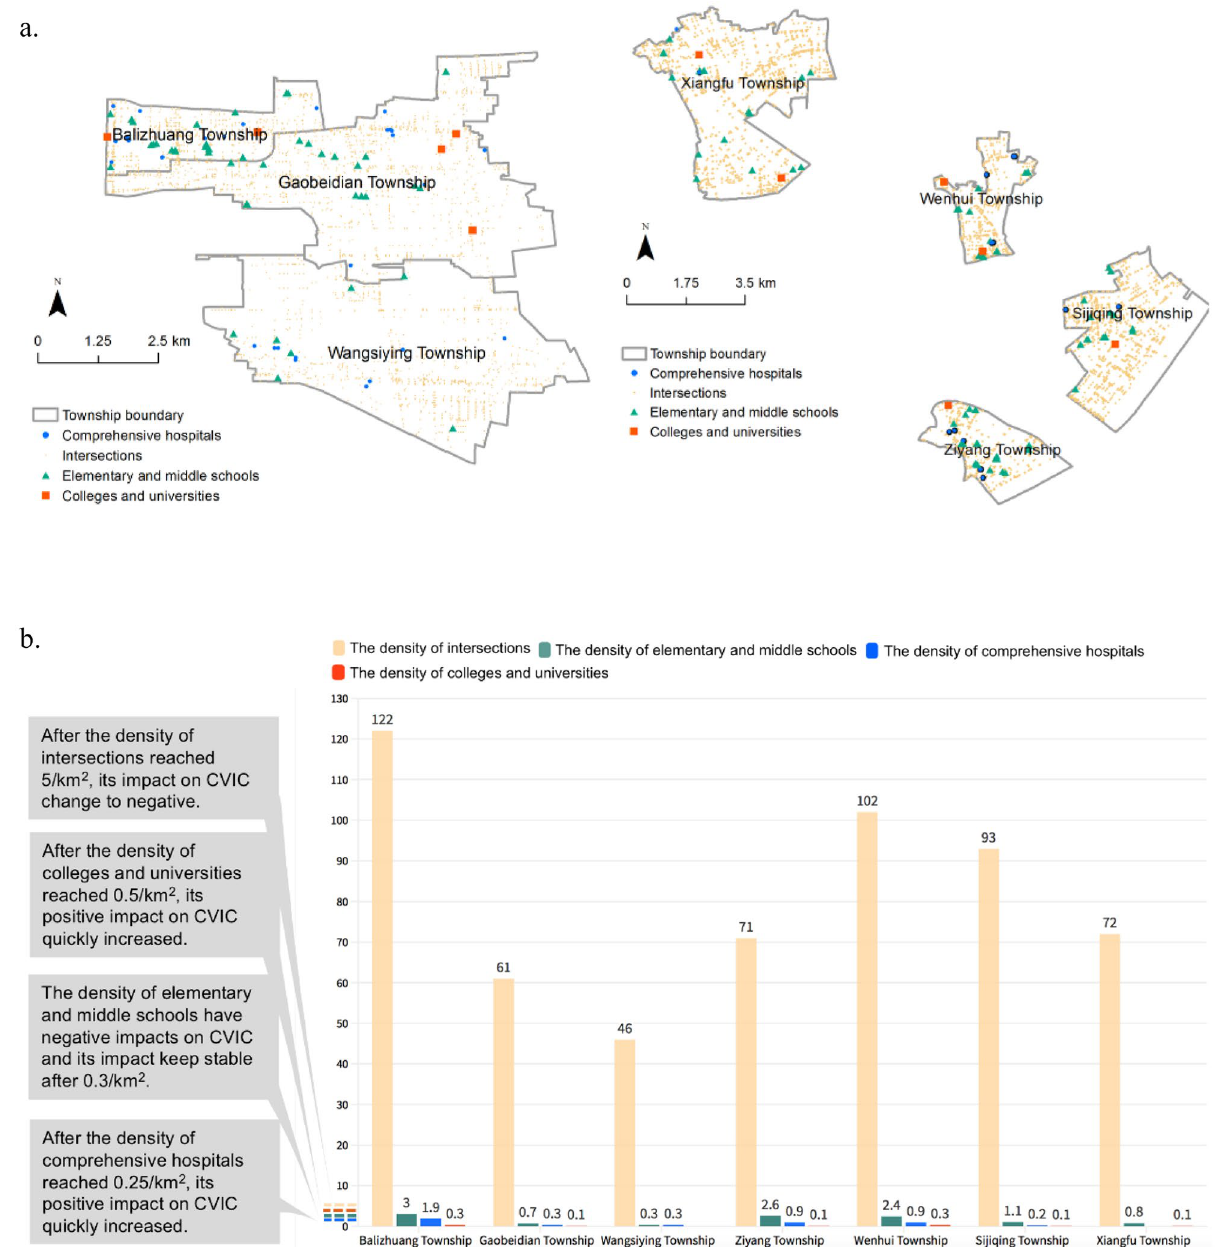
Figure 6. Distributions of major built environment factors to CVIC in selected townships of Beijing and Hangzhou. ( a ) Spatial distributions of townships in Beijing (left) and Hangzhou (right). Created using ArcMap Version 10.2 from ESRI (http:// www. arcgis. com/). ( b ) Statistics of density of intersections, density of elementary and middle schools, density of comprehensive hospitals, and density of colleges and universities; the grey boxes refer to the threshold of every density regarding its impact on the CVIC. Created using Flourish platform (https:// flour ish.